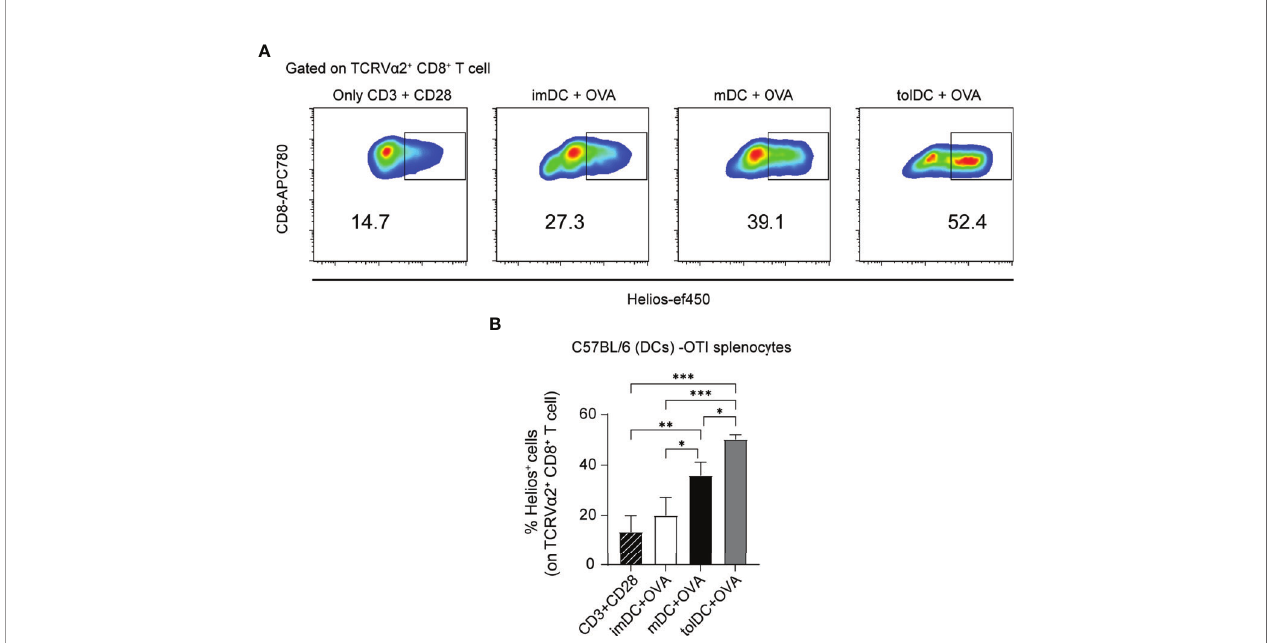
FIGURE 7 | Helios expression in CD8 + T cells from OT-I mice co-cultured with different types of DCs. (A) Representative fl ow cytometry plots gated on TCRV a 2 + CD8 + showing Helios expression in a 3-day co-culture experiment. Bone marrow dendritic cells (DCs): immature (imDC), mature (mDC), and tolerogenic (tolDC) from C57BL/6 were co-cultured with splenocytes from OT-I mice in presence of OVA. As a positive control of stimulation, anti-CD3 and anti-CD28 antibodies were used. (B) Percentage of Helios + cells among TCRV a 2 + CD8 + T cells. The data represent the mean ± SD: *P < 0.05; **P < 0.01; ***P < 0.001 by one-way ANOVA with a Tukey multi-comparison post-test (n = 2 – 4 independent